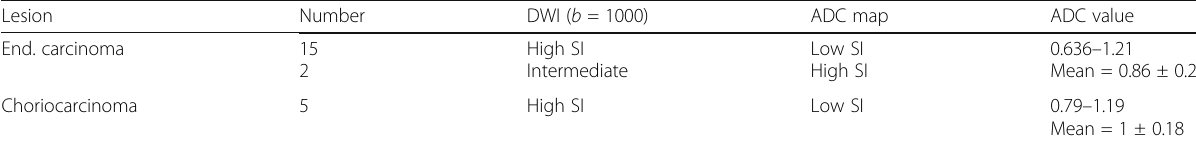
Table 4 DWI and ADC map findings in group II (malignant lesions, n = 22) Lesion Number DWI ( b = 1000) ADC value End.